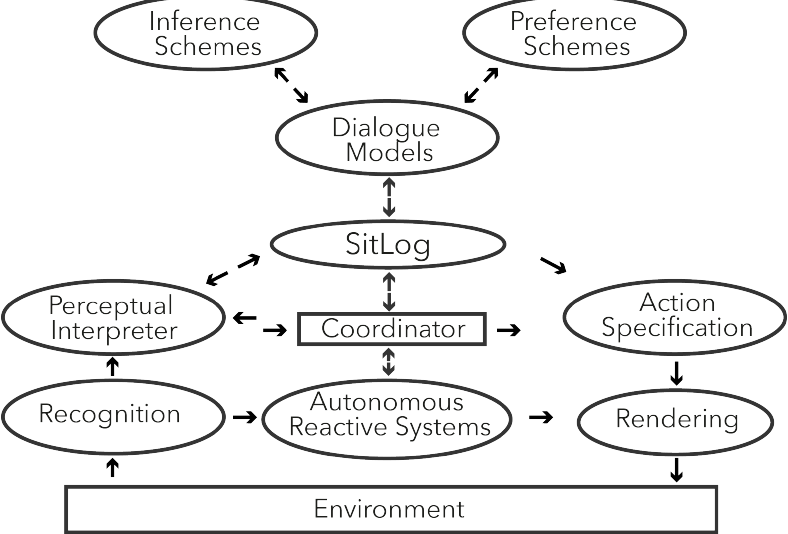
Figure 2. Interaction-Oriented Cognitive Architecture